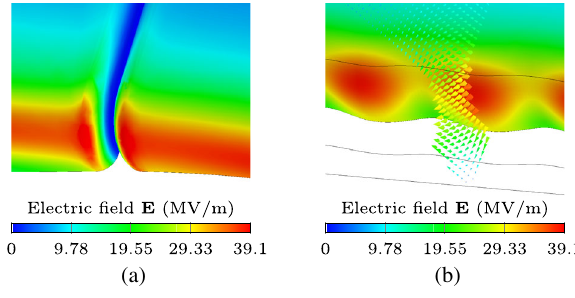
FIG. 5. Electric field on the modulated vane tip. The overall maximum occurs at the gap between the two RFQ modules with 39 . 1 MV = m (a). Neglecting the gap, the maximum is located in the bunching section with 36 . 5 MV = m (b). The plots use the same color scale for easier